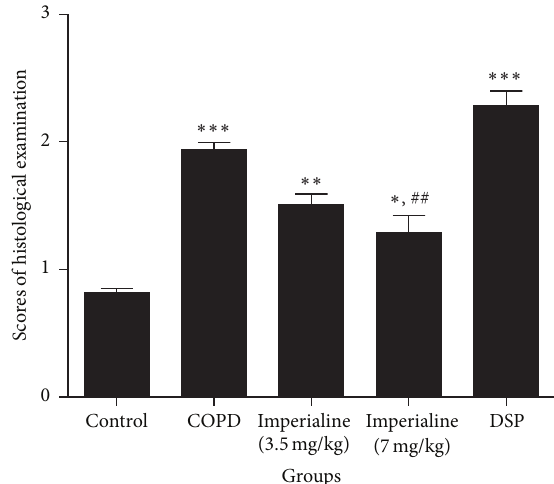
Figure 7: The scores of histological examination of lung tissues of rats in different groups. Results were expressed as the mean ± SEM ( 𝑛 = 10 ). Significant differences compared with the control group were designated as ∗ 𝑃 < 0.05 , ∗∗ 𝑃 < 0.01 , and ∗∗∗ 𝑃 < 0.001 . Significant differences compared with the COPD group were designated as ## 𝑃 < 0.01